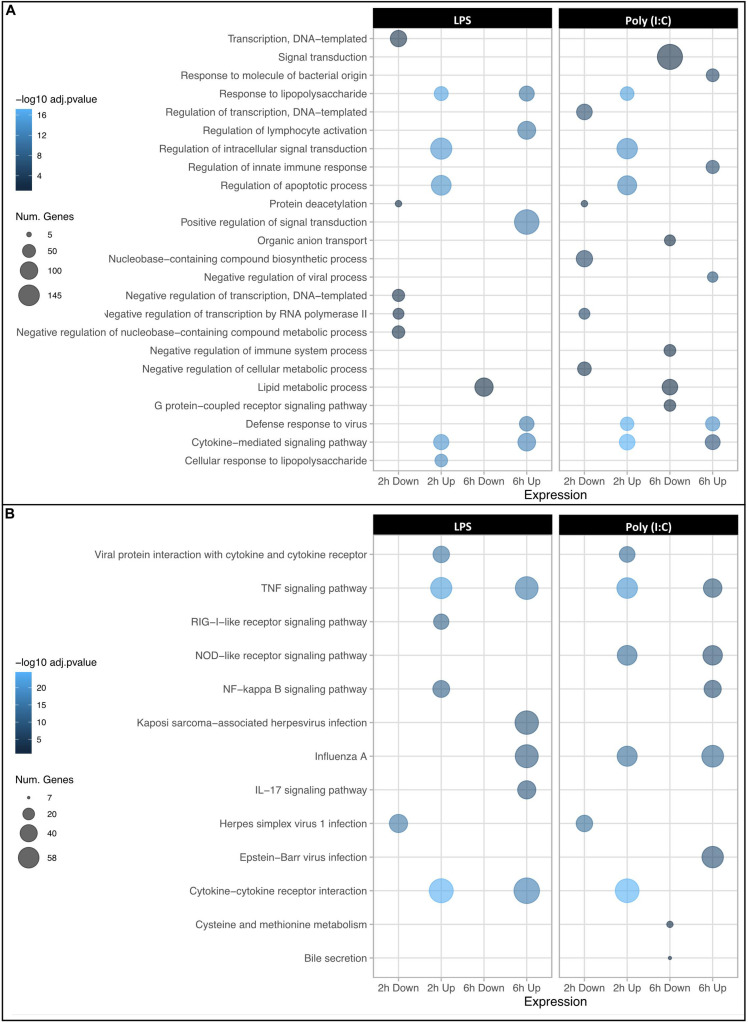
Dot plots showing GO term enrichment for DEGs. The top 5 most significantly enriched biological processes (A) and KEGG pathways (B) are displayed. The X axis corresponds to downregulated and upregulated genes at 2 and 6 h post stimulation, and Y axis represents the GO terms. The size and color of the dots corresponds to the number of DEGs associated with the GO terms and pathways and the P-values of hypergeometric tests, respectively.